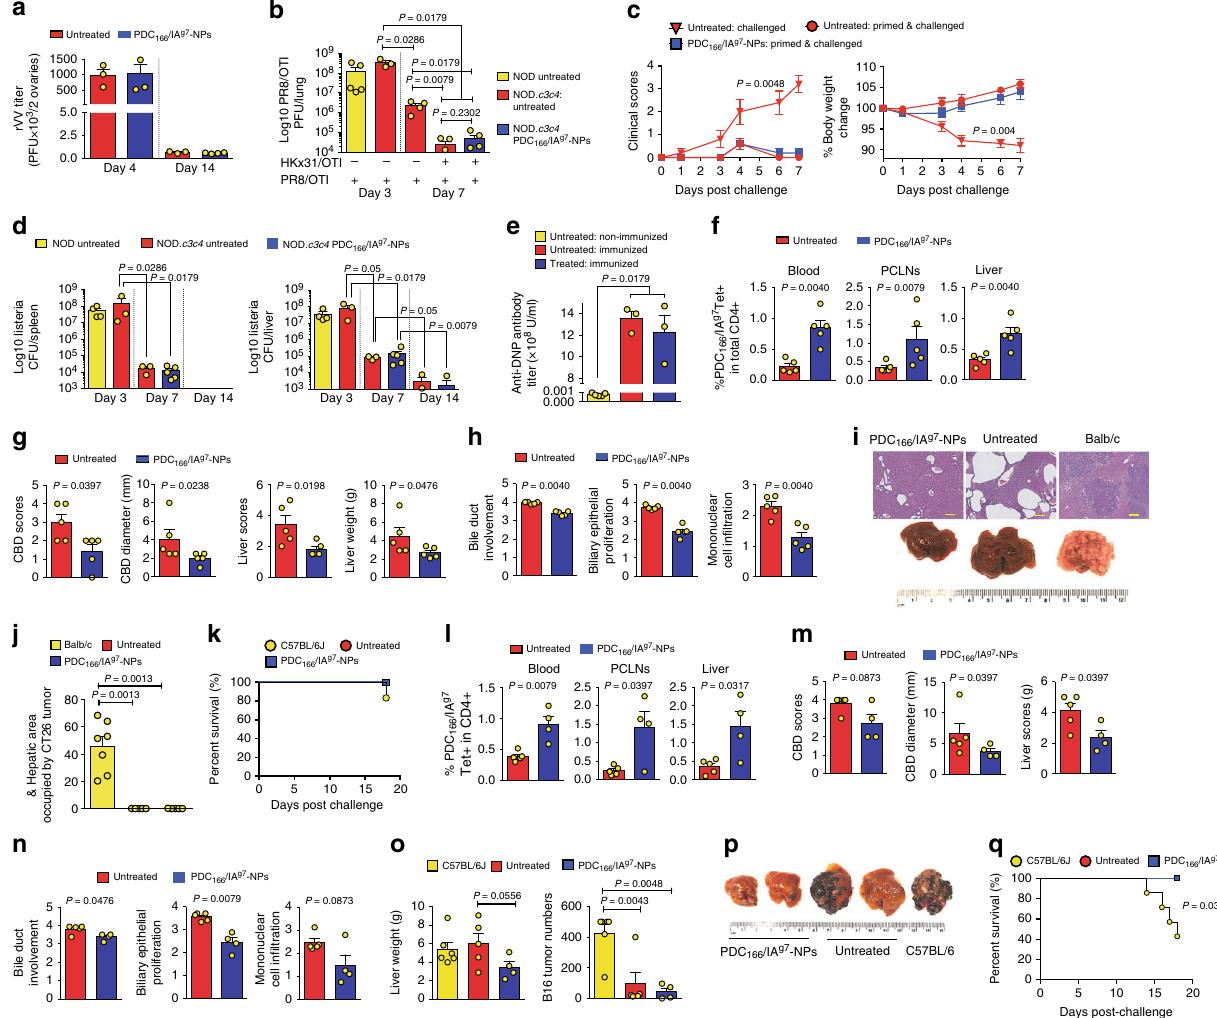
Fig. 10 Liver disease-relevant pMHCII-NPs spare general immunity. a rVV titers in ovaries 4 and 14 days after rVV infection ( n = 3 – 4/group). b In fl uenza viral titers in lungs 3 and 7 days after infection with PR8 with or without HKx31 priming ( n = 5, 3, 4, 5 and 5; left to right). c Clinical scores and body weight ( n = 5 mice/group). d Colony-forming units of L. monocytogenes in the spleen and livers 3, 7, and 14 days after infection ( n = 4, 3, 3, 5, 3 and 4; left to right). e Serum anti-DNP antibody titers upon KLH – DNP immunization ( n = 3/group). f – k Percentages of tetramer + cells ( f ), macroscopic PBC scores and liver weight ( g ), microscopic PBC scores ( h ), liver images ( i ), microscopic tumor scores ( j ), and survival rates ( k ) of untreated vs. PDC 166 – 181 /IA g7 -NP-treated NOD. c3c4 ( n = 5/group) or untreated Balb/c mice ( n = 7) challenged with CT26 cells (overlapping 100% survival in untreated vs. PDC 166 – 181 /IA g7 -NP- treated mice). Scale bar in ( i ): 100 μ m. l – p Percentages of tetramer + cells ( l ), macroscopic ( m ), and microscopic PBC scores ( n ), and liver weight and metastasis number ( o ), and liver images ( p ) of untreated vs. PDC 166 – 181 /IA g7 -NP-treated NOD. c3c4 ( n = 5 and 4) or untreated B6 mice ( n = 6) challenged with B16/F10 cells. q Survival rates of the mice in l – p (overlapping 100% survival in untreated vs. PDC 166 – 181 /IA g7 -NP-treated mice). Data correspond to mean ± SEM. P values were compared via Mann – Whitney U except for k , q (log-rank), or c (two-way